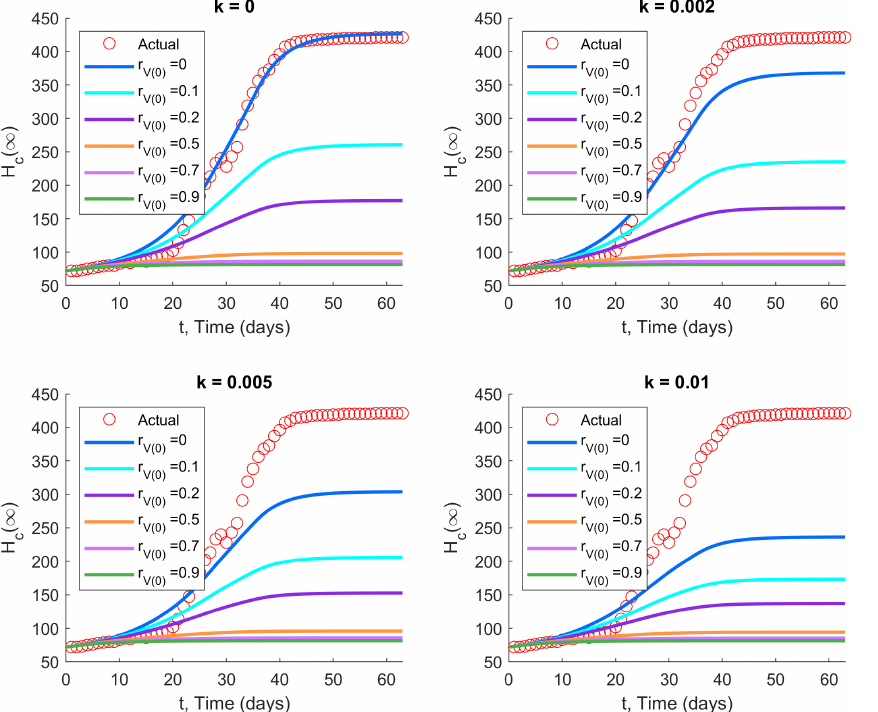
Figure 3. Impact of vaccination with two vaccine types on the second wave of COVID-19 in Hong Kong: ( ε , α , β , γ , δ ) = ( 0.48,0.5,0.14,1,0.1 ) and v e = 0.774, with initial values as in Table 2. Increasing the initial vaccination coverage ( r V ( 0 ) ) and/or the subsequent vaccination rate ( k ) significantly reduces the cumulative number of hospitalizations and isolations.